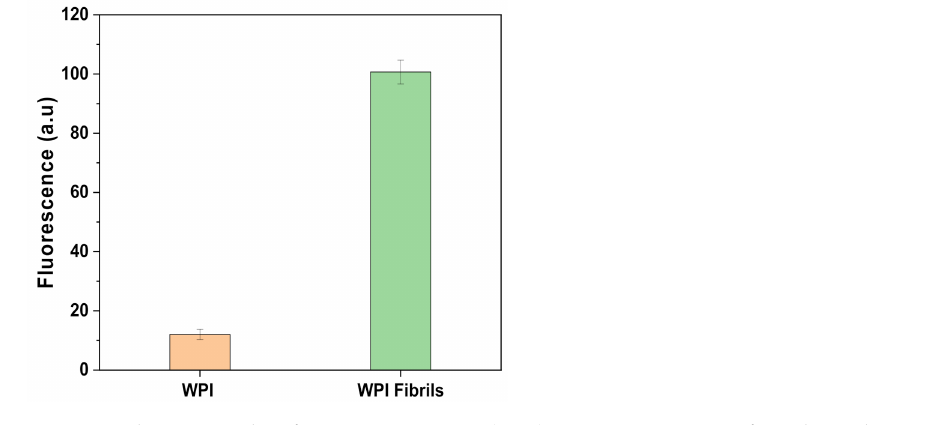
Figure 1. ThT test results of: 2.5% WPI at pH 2 (WPI); 2.5% WPI at pH 2 after 5 h incubation at 90 ◦ C under stirring at 350 rpm (WPI Fibrils). λ ex = 440 nm; λ em = 486 nm. Error bars represent the standard deviation (SD).